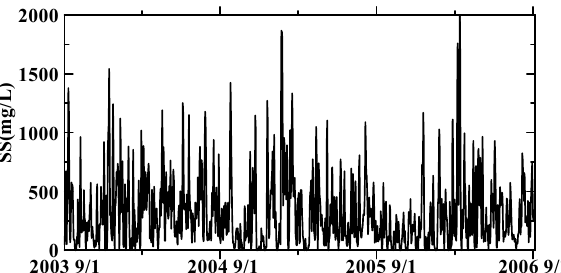
Figure 23. Turbidity in the lake estimated from the daily wind velocity at Sidi Ahmed Air Base.